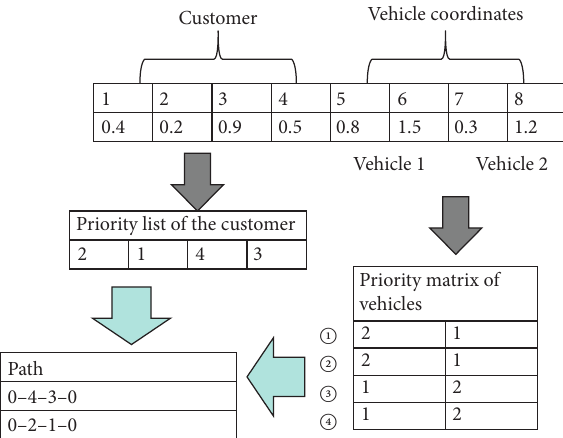
Figure 2: SR-1 method